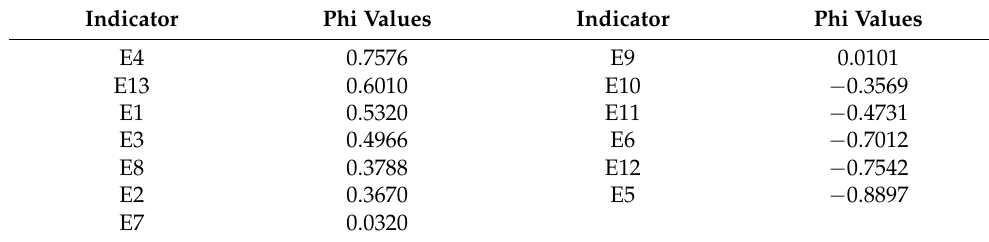
Table 10. PROMETHEE II results for environmental aspect in healthcare